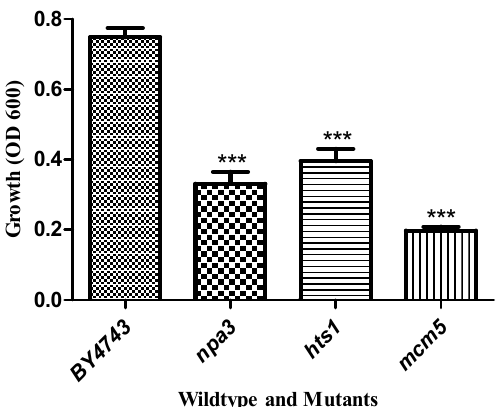
Figure 6. Graph showing the effects of 50 μ M of allicin after 15 h on the growth of wildtype BY4743 and Δ npa3 , Δ mcm5 and Δ hts1 mutants in CSM. Values represent mean ± S.D. *** p < 0.001.